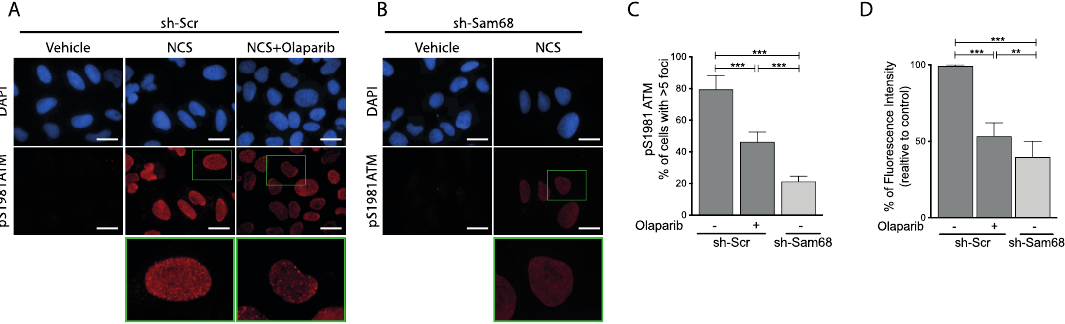
Figure 1. Sam68 is required for DDR activation in PC cells. ( A , B ) Representative immunofluorescence images of HEK293T cells infected with control (sh-Scr) lentivirus ( A ) or expressing RNA small interference for Sam68 (sh-Sam68) ( B ) treated, or not (vehicle), with NCS (3 0′ , 500 ng/mL). Olaparib (10 µM, Selleck) was added 1 h before NCS treatment. After treatments, cells were fixed and stained with pS1981ATM antibody. ( C , D ) Bar graphs show the quantification of cells with more than five nuclear foci ( C ) and the fluorescence intensity relative to control ( D ). Bars, 10 μ m, (n = 3; mean ± s.d.; ** p < 0.01, *** p < 0.001, t test).